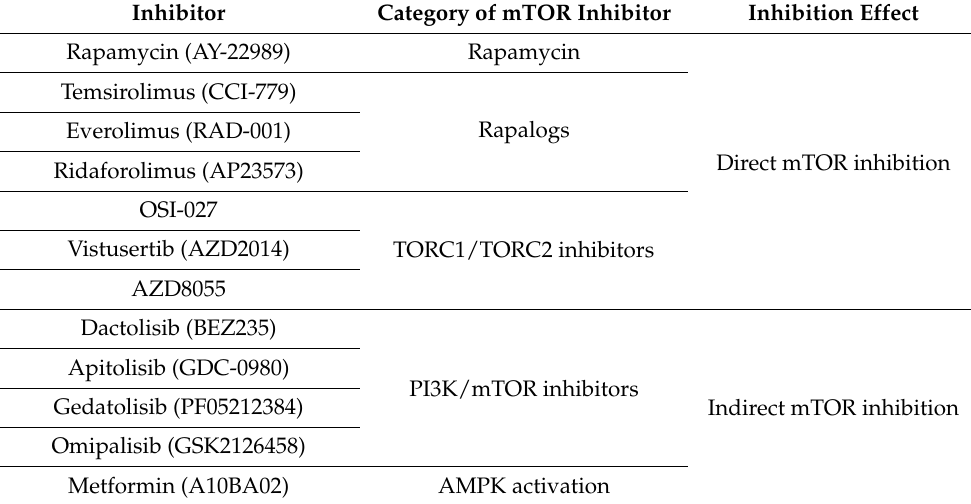
Table 1. A representative list of mTOR